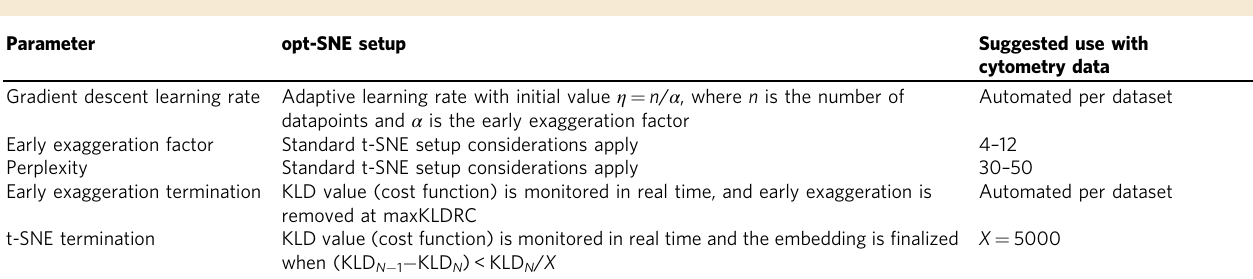
Table 2 Summary of t-SNE optimizations proposed in opt-SNE work fl ow